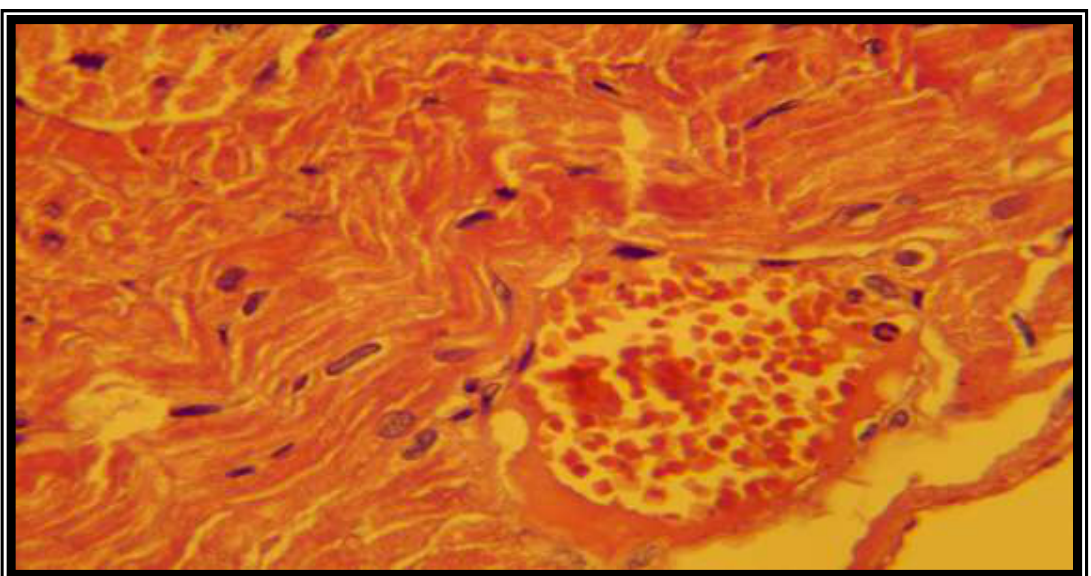
Figure (10) Histological section of heart treated H 2 O 2 Plus black currant complete concentrate regression of lesion in the muscle fiber & wall of pulmonary artery H.E